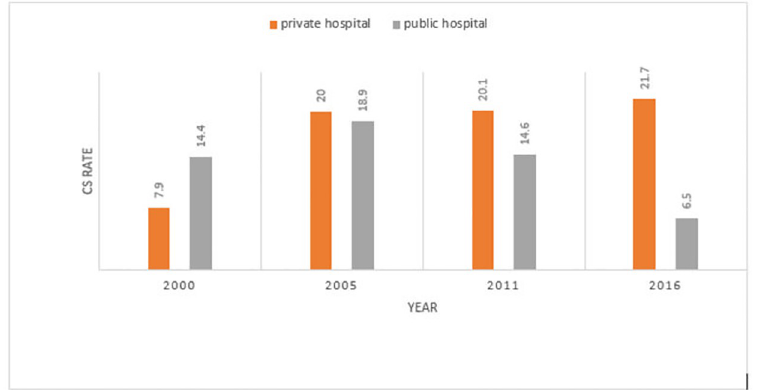
Fig 1. Magnitude of CS rate among private hospital, public hospital (2000–2016) survey year.